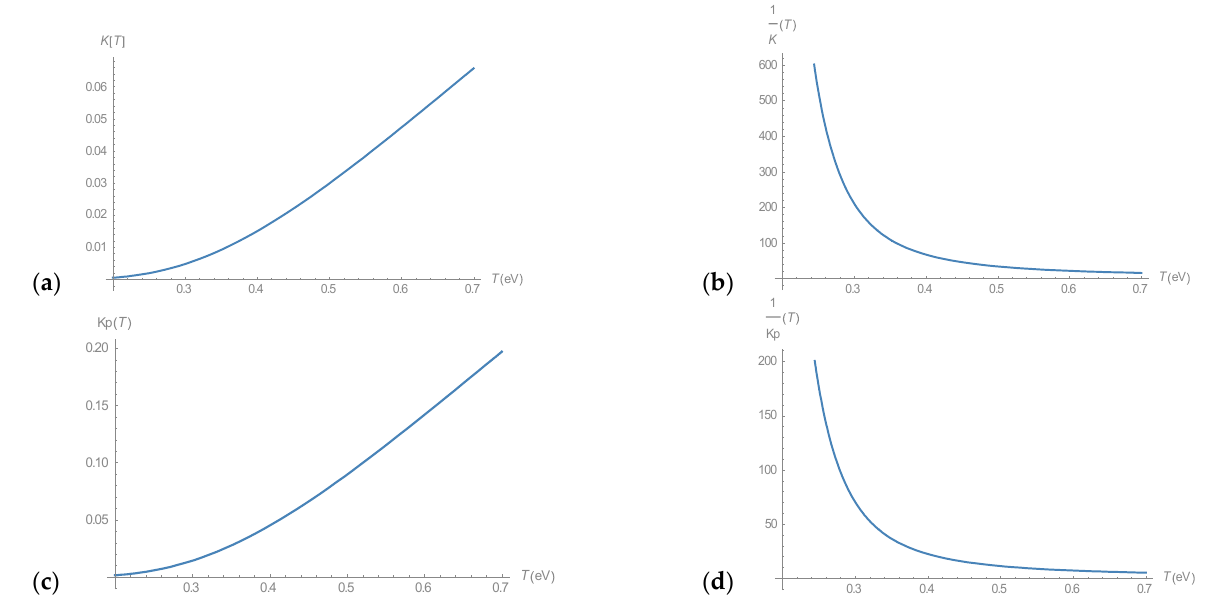
Figure 3. A dependence of equilibrium constant on mean-temperature T ( a ) K o (T) for the orto -positronium; ( b ) a reverse constant 1/K o for the orto -positronium; ( c ) K p (T) for the para -positronium; ( d ) a reverse constant 1/K p for the para -positronium.